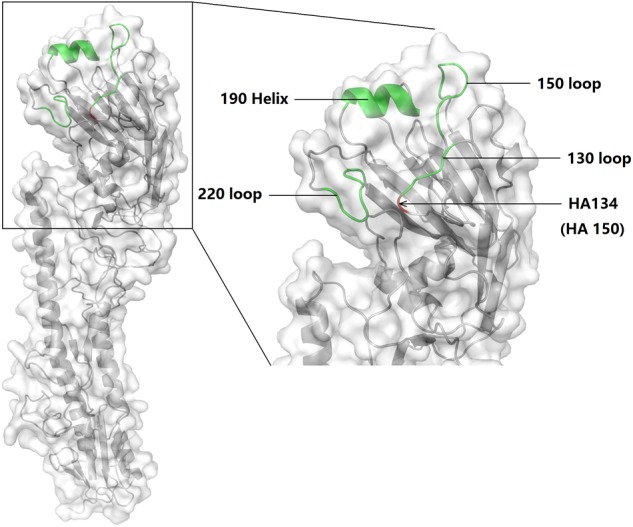
Schematic of the HA subunit and receptor binding site of 6D2. The 130 loop, 150 loop, 220 loop, and 190 helix were labeled. HA 150 [in another study (Auewarakul et al., 2007), this point is referred to as HA134] is indicated with an arrow. The molecular model was built using PyMol (v1.8.0.0; Schrödinger, LLC).